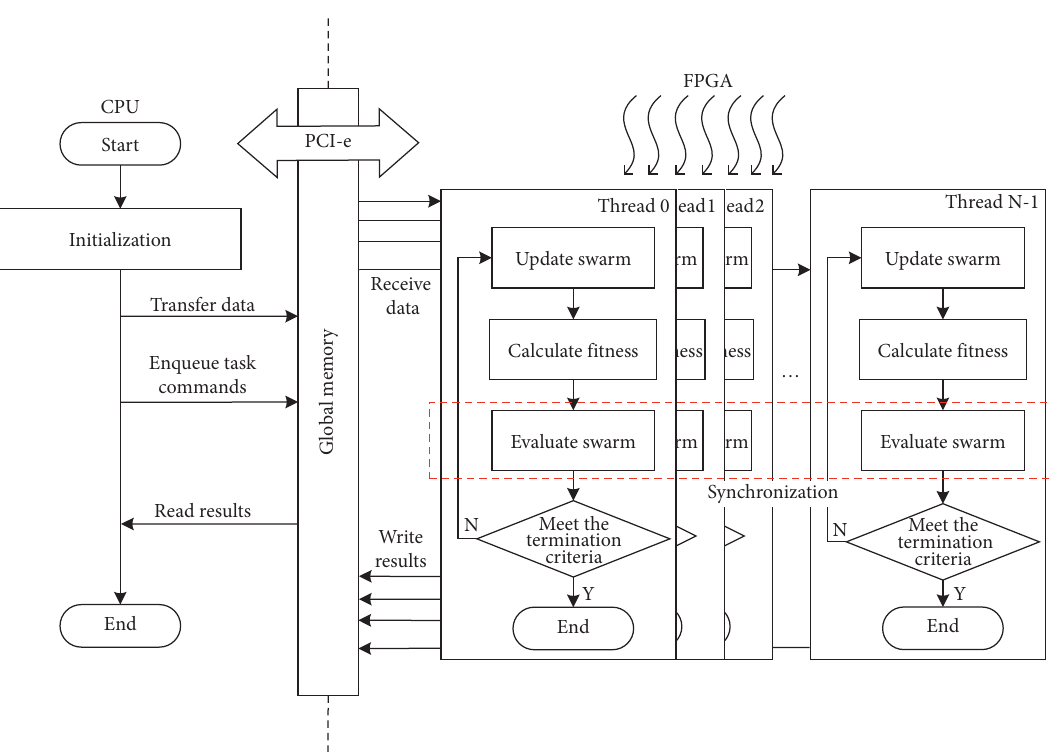
Figure 5: Framework of the All-FPGA parallel model-based PWOA (PWOA-AFPM).